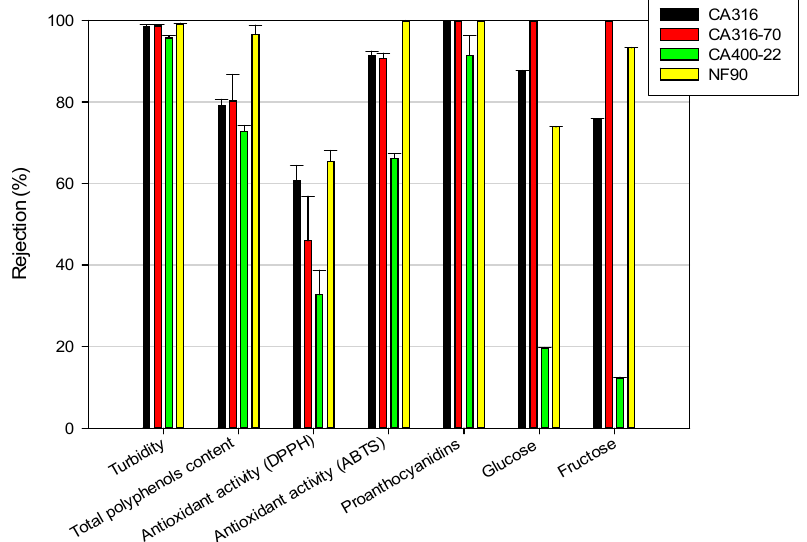
Figure 3. NF rejections to specific compounds and characteristics of grape pomace extract. Membrane: CA316, CA316-70, CA400-22, and NF90.